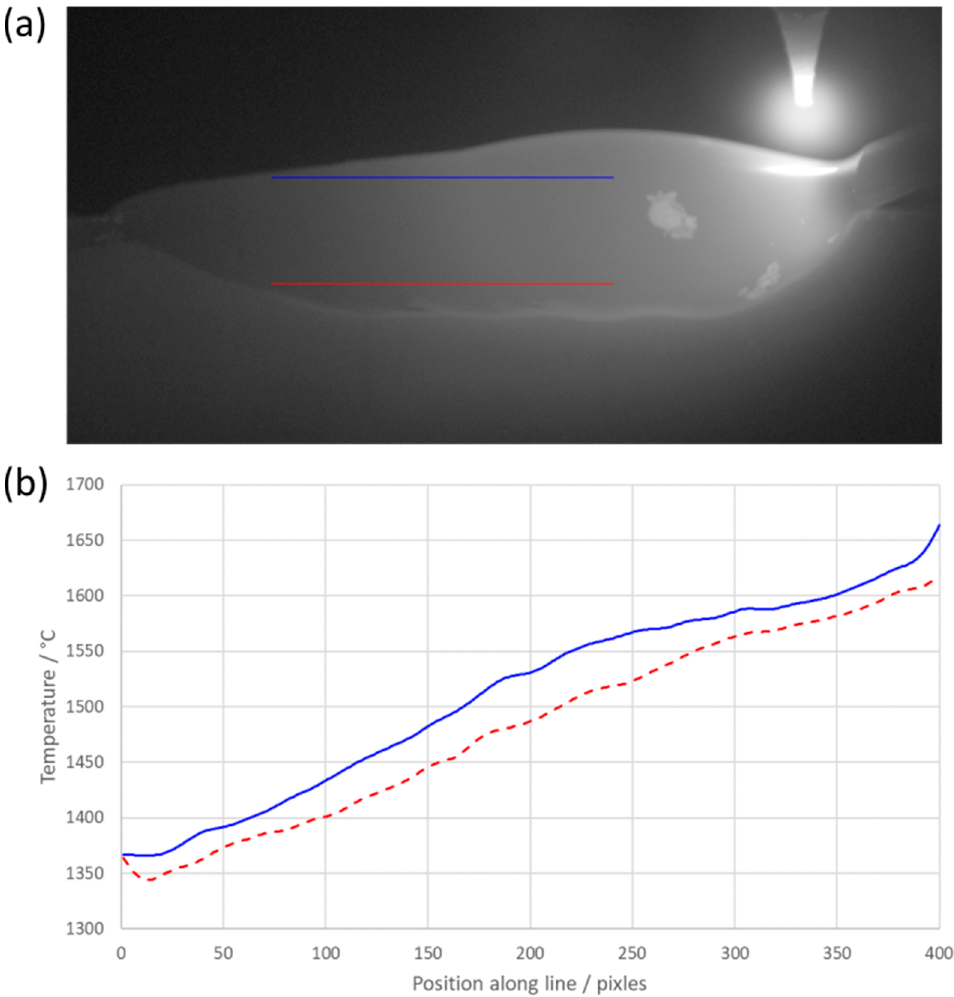
Figure 6. Temperature profile lines of the weld pool: ( a ) a still frame from the thermal imaging with both line profiles overlaid; ( b ) a graphical representation of the temperature profiles varying with position. The color of the lines corresponds to the color of the line profiles in a).